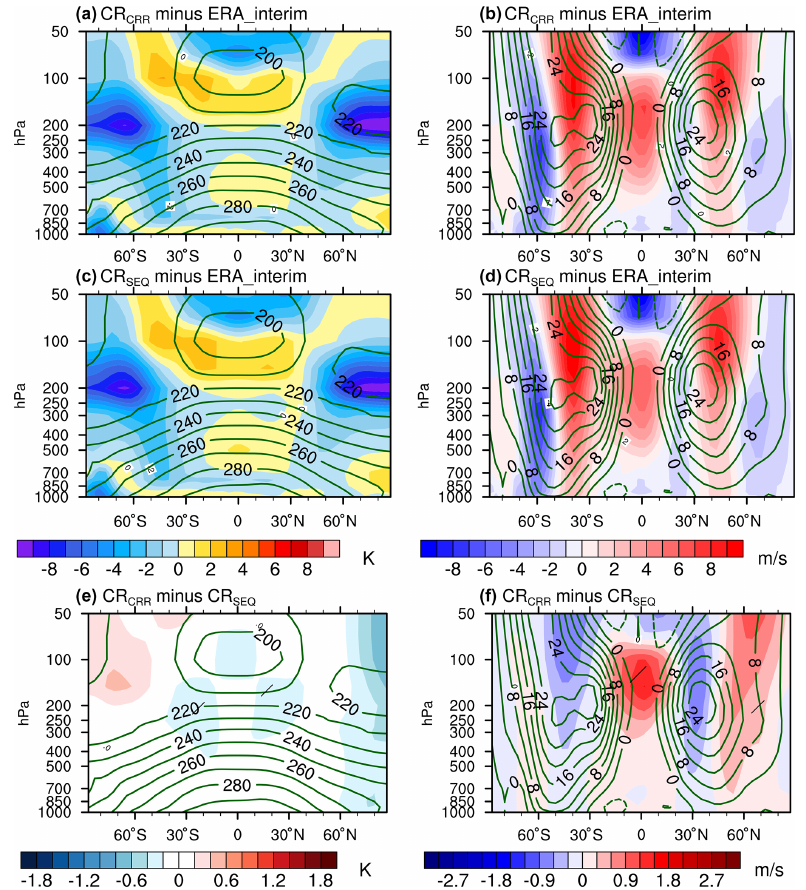
Figure 16. Mean bias in zonal-mean temperature (K) and zonal wind (ms − 1 ) in the (a, b) concurrent and (c, d) classical radiation experiments relative to ERA-Interim for the period 1980–2013 (shading) and the climatological mean from ERA-Interim (contours). Differences in (e) zonal-mean temperature and (f) zonal wind between the concurrent and classical radiation for the period 1980–2013. Hatching indicates significance at the 95% confidence interval using the Student’s t